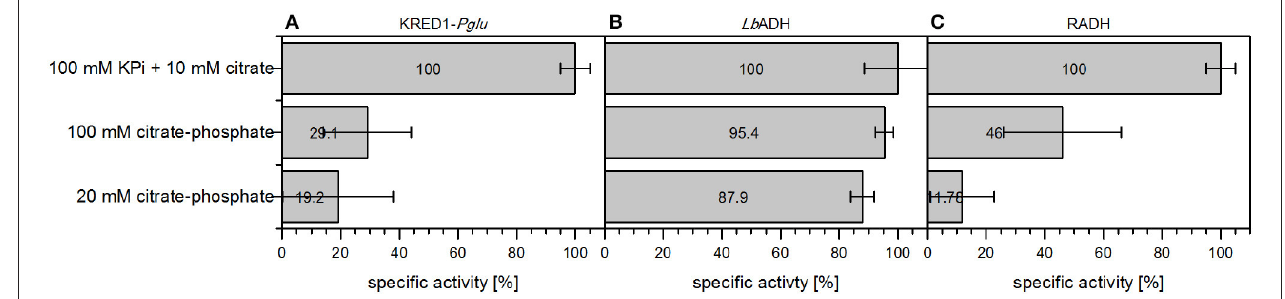
FIGURE 8 | Comparison of citrate-phosphate buffer against citrate addition in terms of specific initial activities of different oxidoreductases. The required cofactor for the NADPH-dependent oxidoreductases is regenerated by either 10mM citrate supplementation in an environment using 100mM KP i buffer or directly applying citrate as 20 or 100mM citrate-phosphate buffer. (A) was performed with KRED1- Pglu at pH 8, (B) was performed with Lb ADH at pH 6.5, and (C) was performed with RADH at pH 8. 0.34U mg − 1 KRED1- Pglu CCE, 3.56U mg − 1 Lb ADH CCE, and 2.4U mg − 1 RADH CCE were normalized to 100 % specific activity. n =